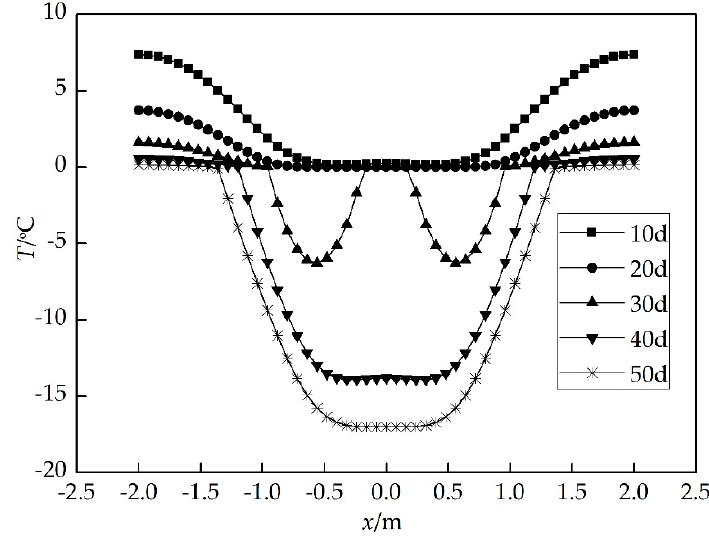
Figure 10. Temperature distribution in the intersection.